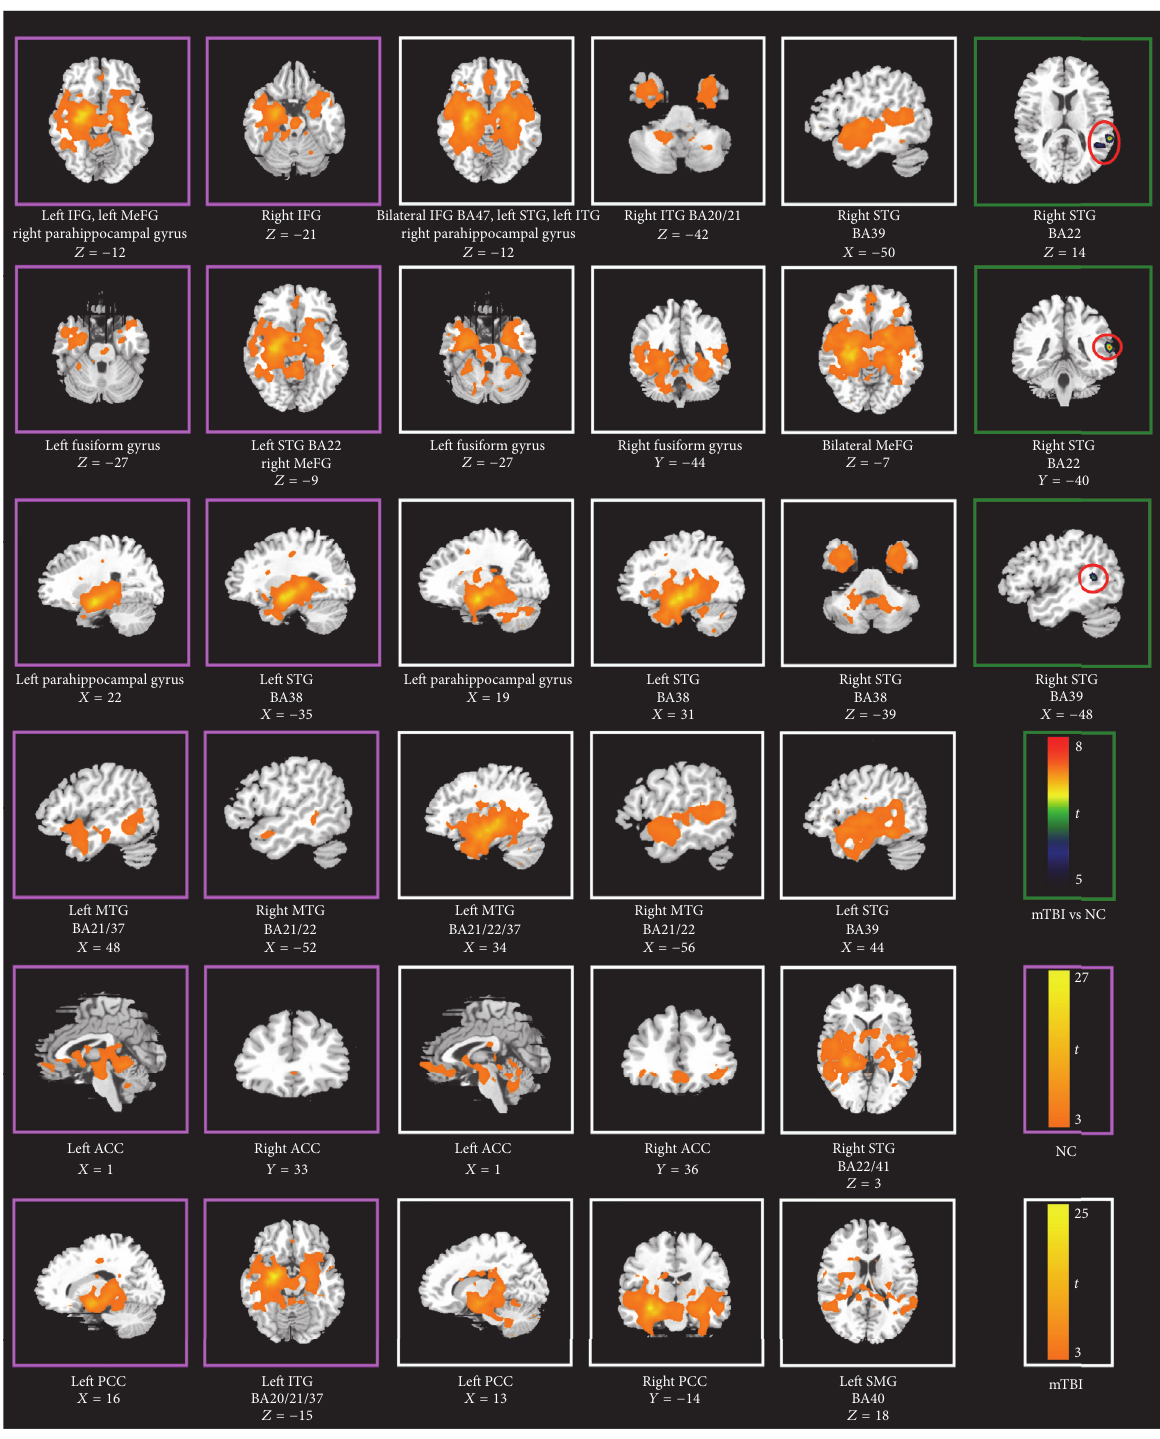
Figure 1: Functional connected hippocampal networks concerning episodic memory in normal controls and mTBI survivors, as well their